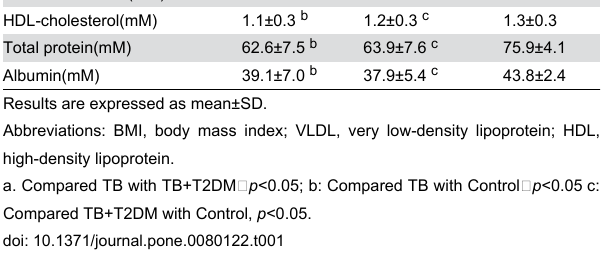
Table 3. Correlation of characteristics with BMI among different